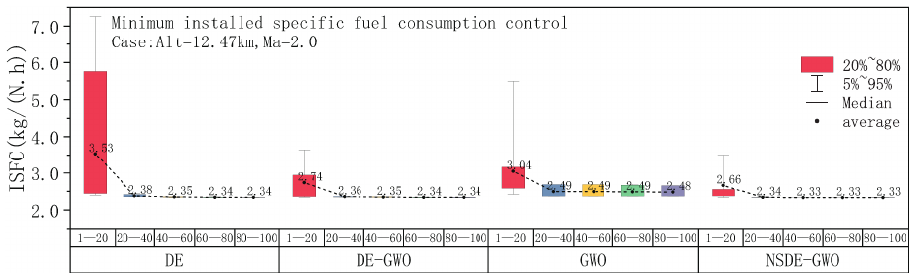
Figure 9. Box plots of different iterative algorithm optimization process in minimum installed specific fuel-consumption